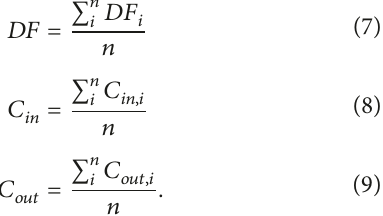
mode diameters of 0.5 𝜇 m and geometric standard